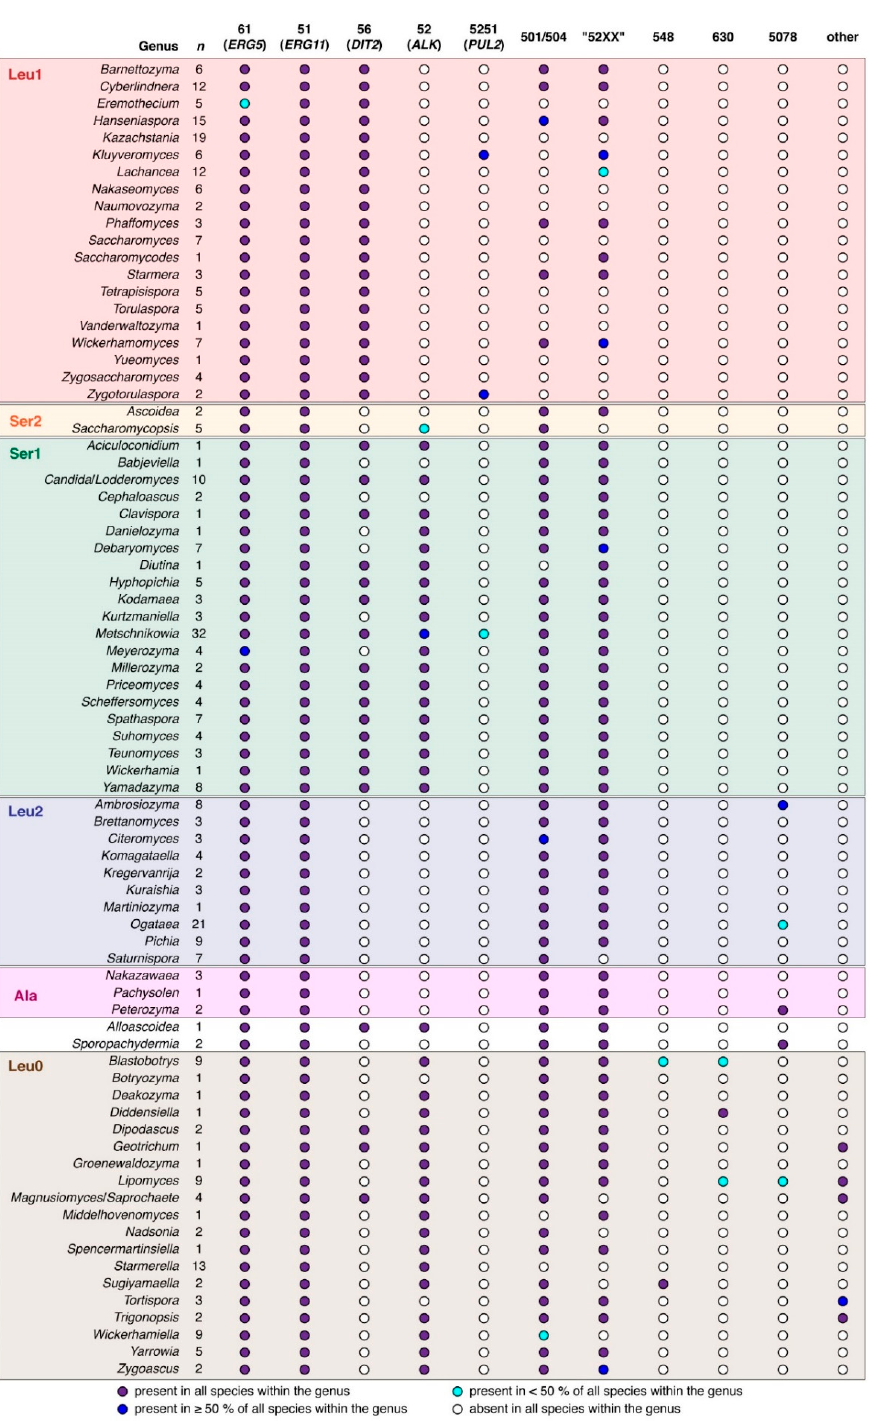
Figure 2. Taxonomic distribution of CYP families among the budding yeasts. Genera are organized with respect to clade [24]. The number of species surveyed within each genus ( n ) is indicated. The color of circles represent the occurrence of each CYP category (either individual CYP families or larger clusters of related CYP families) within each individual genus. Suspected pseudogenes were scored as “absent”. The CYP category “other” denotes CYP families detected exclusively in a small number of basal budding yeast genera. These CYP families are described in greater detail in Table